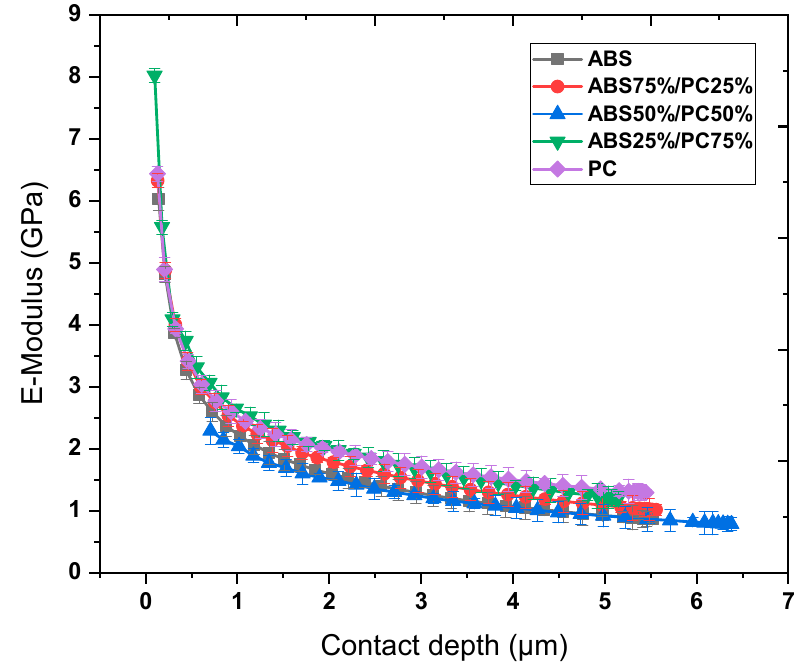
Figure 5. Modulus of neat ABS, PC, and blends of ABS/PC.